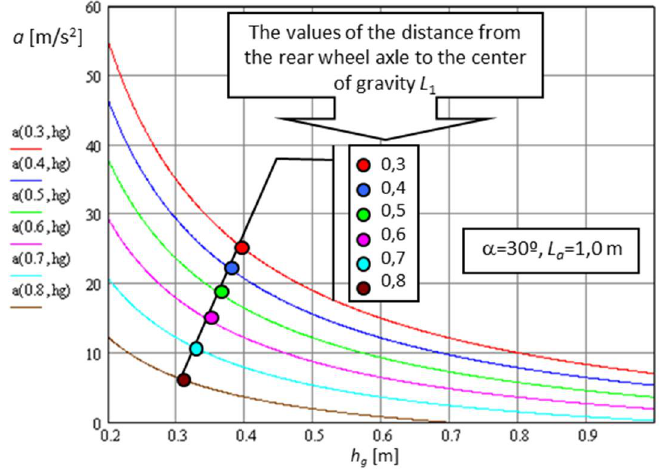
Figure 15. The variation in the maximum deceleration at braking on a 30º slope as a function of the center of mass.